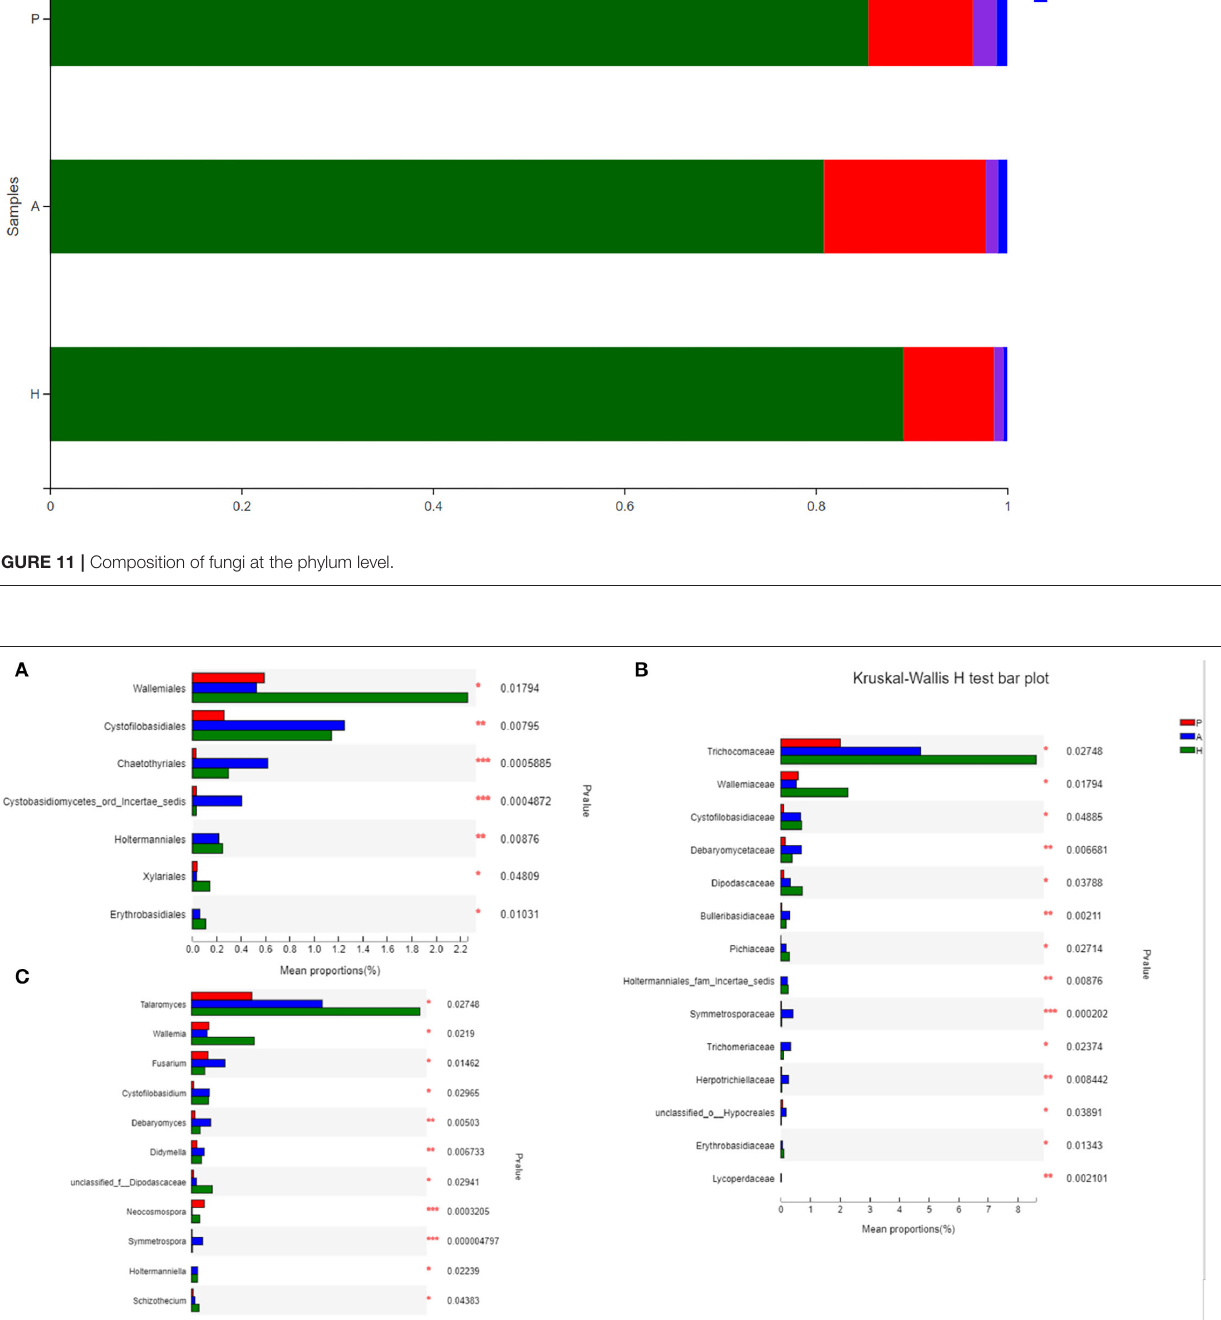
Frontiers in Microbiology |